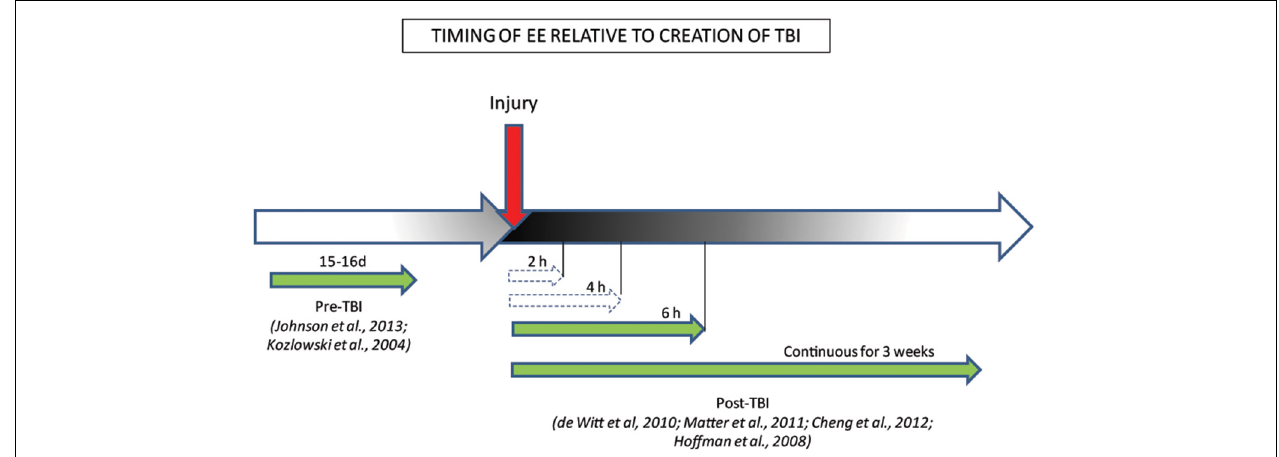
FIGURE 2 | Behavioral benefits conferred by the timing/duration of EE relative to creation of TBI. The efficacy of EE treatment when administered pre/post-injury is represented by green full-line arrows which